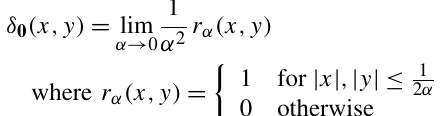
Figure 2. The nearer a sample point x k is located to a grid point, the larger the weight assigned to it. Grid point [ i,j ] , e.g., receives a weight of ( 1 − w x ) · ( 1 − w y )